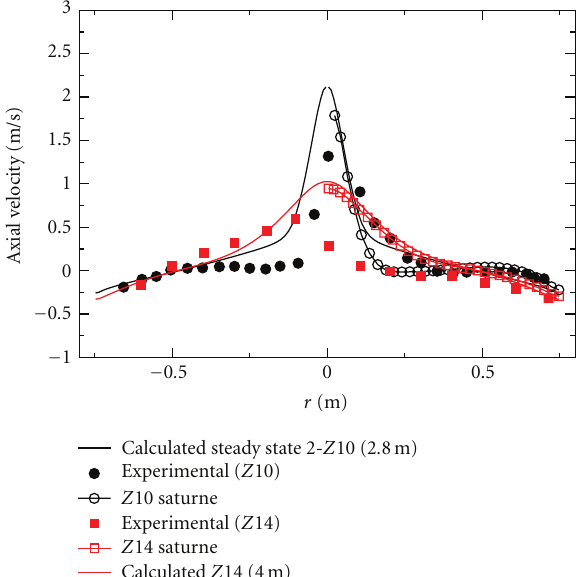
Figure 13: Radial profile of the axial gas velocity at Z 10 = 2 . 8 m and Z 14 = 4m: steady state 2.